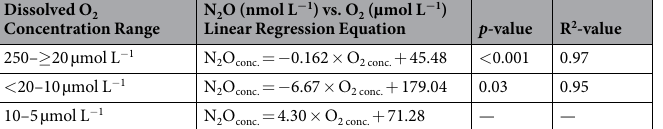
Table 1. Results from simple linear regression analyses of N 2 O vs. DO at different DO concentration ranges. The results shown here were obtained using data shown in Fig. 2a. The regression equations were used in conjunction with the DO concentrations measured during the IFM13 glider survey of the eddy (see Methods section) in order to estimate the bulk amount of N 2 O inside the suboxic eddy.